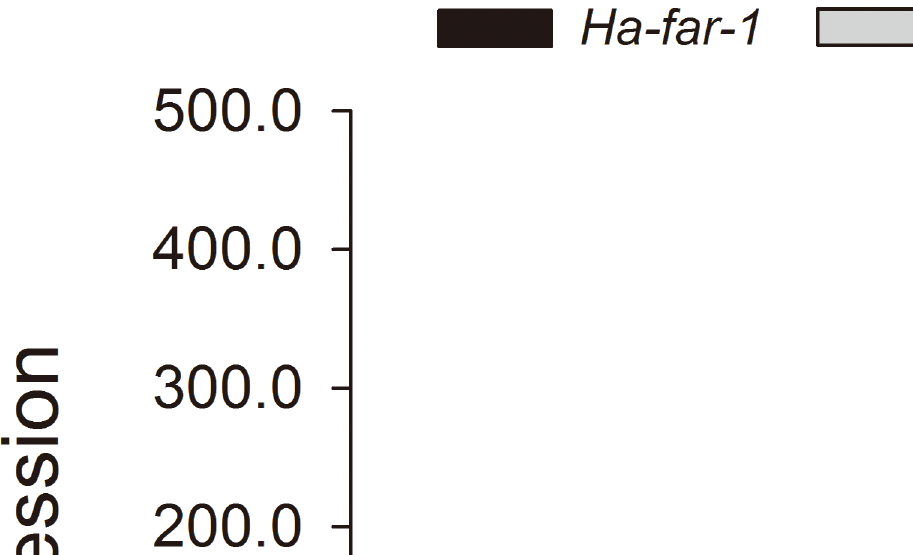
Fig 9. Relative expression of Ha-far-1 and Ha-far-2 in five developmental stages was determined using RT-qPCR. The relative expression was calculated with 2 - ΔΔ Ct method by normalizing with two internal reference β -actin gene and GAPDH gene and presented as the change in mRNA level in various nematode developmental stages relative to that of Ha-far-2 at preJ2. preJ2: pre-parasitic second-stage juvenile; J2, J3 and J4: second-, third- and fourth-stage juvenile, respectively; F: